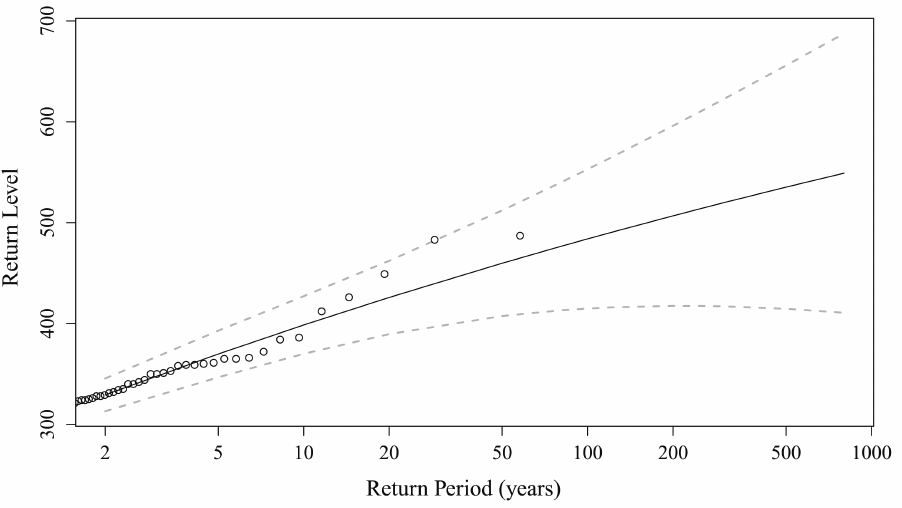
Figure 10. RL plot of the maxima values for daily data with GP distribution. The dashed lines indicate 95% CIs of the return value, the solid line is the regression line, and the point indicates the RL value for NNN